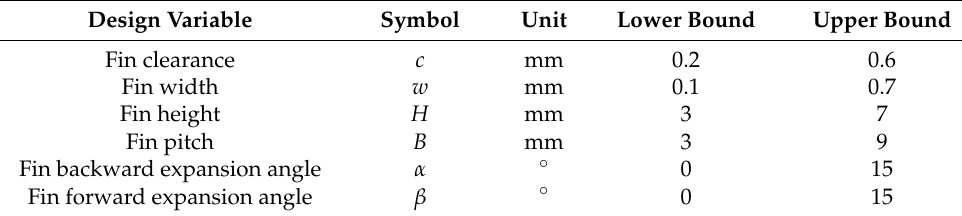
Figure 1. Structure of straight-labyrinth seal. Table 1. Design variables and design space.